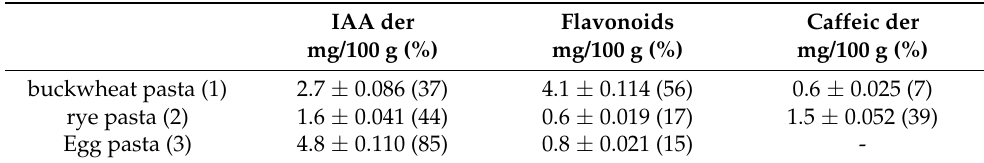
Table 1. Caffeic derivatives (caffeic der), flavonoids and indoleacetic acid derivative (IAA der) content in cooked pasta samples. Data are the mean of three determinations (standard deviation < 5%). The percentage of single classes of identified compounds is shown in brackets.